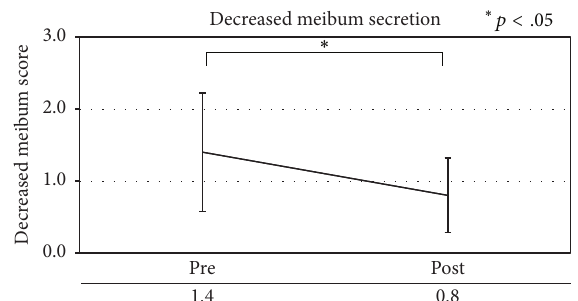
Figure 8: Superficial punctate keratopathy in patients with meibo- mian gland